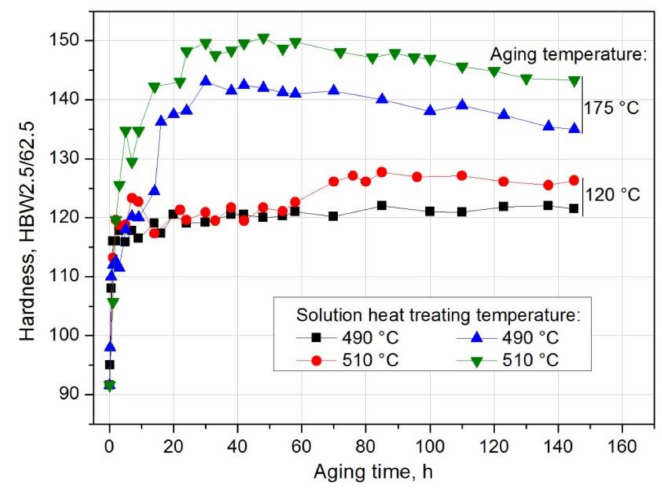
Figure 17. Effect of solution heat treatment temperature (490 ◦ C and 510 ◦ C) and time of artificial aging at 120 ◦ C and 175 ◦ C on the hardness of the EN AW-2017A aluminium alloy.